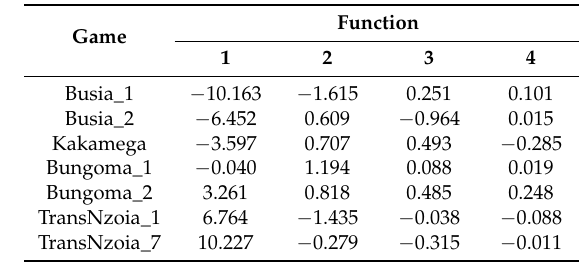
Table A11. Wilks’ Lambda for test of functions 1 through 4.